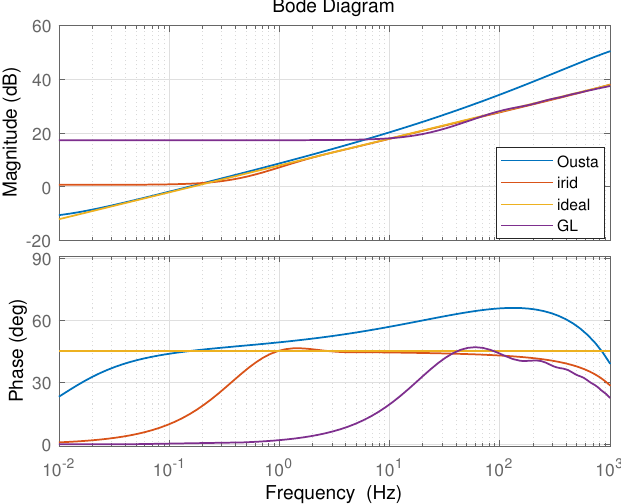
Figure 6. Case 3: 24th order discretization approximate Bode graph of s 0.5 in the frequency band [0.01, 10000]Hz.